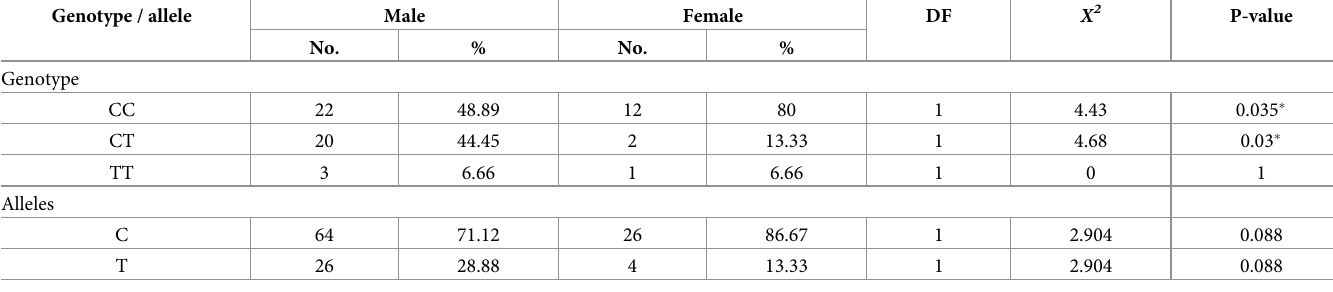
Table 5. OXTR polymorphism rs2268491 in ASD males (n = 45) and females (n = 15). Genotype /